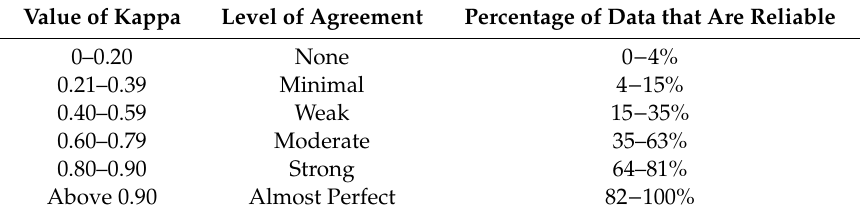
Table 3. Cohen’s Kappa Level of Agreement. Adapted from: McHugh